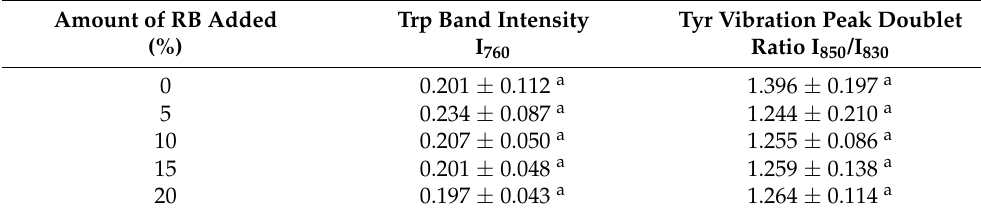
Table 3. Band intensities of protein side chain groups in RB-SPI plant-based simulated meat. Amount of RB